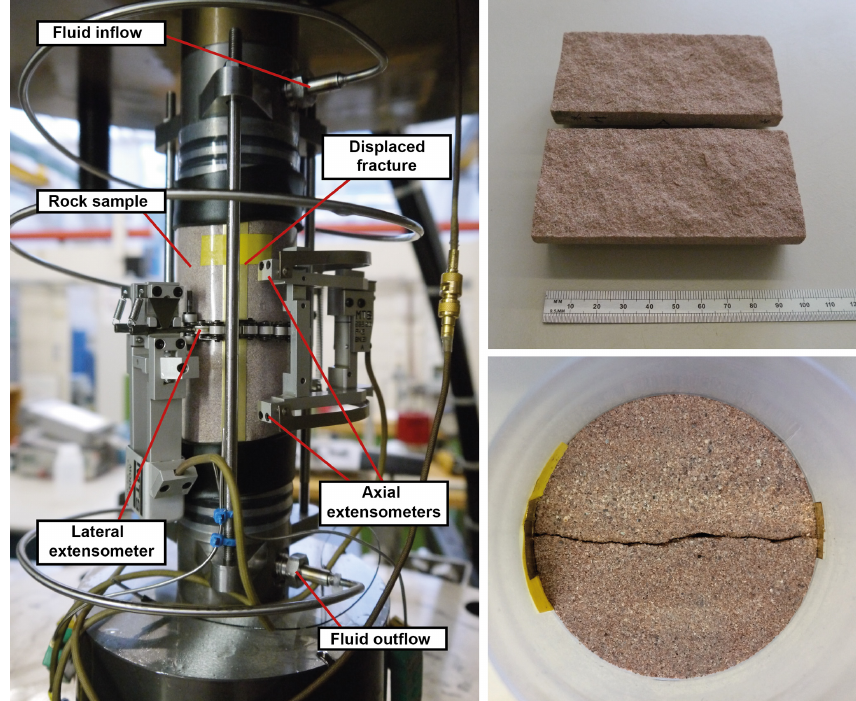
Figure 1. Experimental setup and Flechtinger sandstone samples (SBT6-BE) containing a shear-displaced tensile